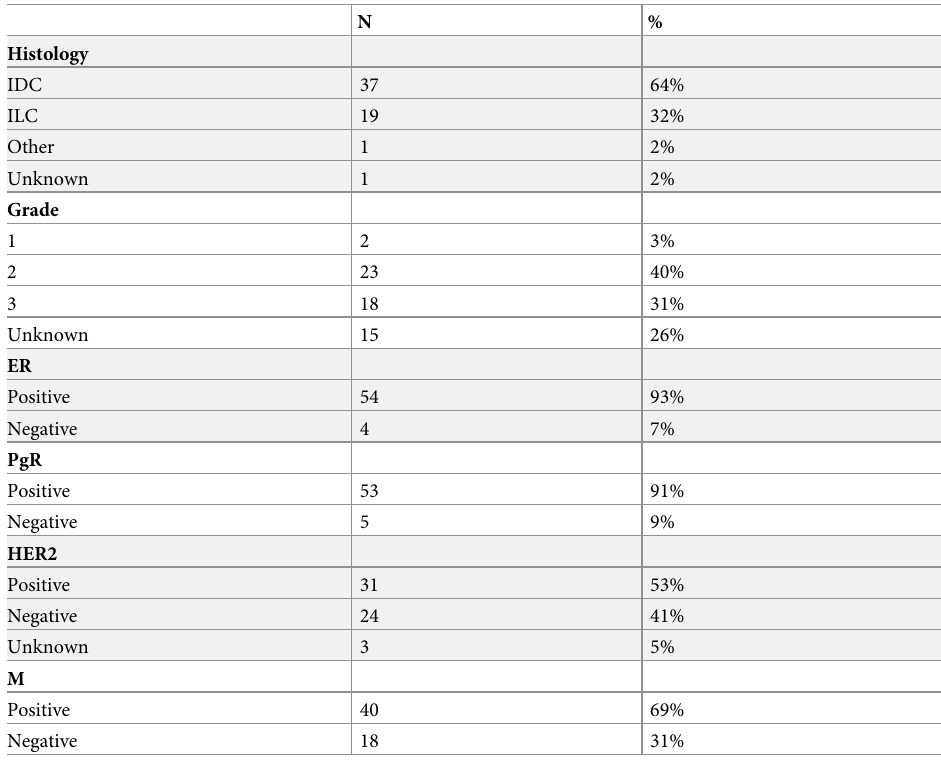
Abbreviations: IDC = invasive ductal carcinoma; ILC = invasive lobular carcinoma; ER = oestrogen receptor; HER2 = human epidermal growth factor 2; M = metastatic